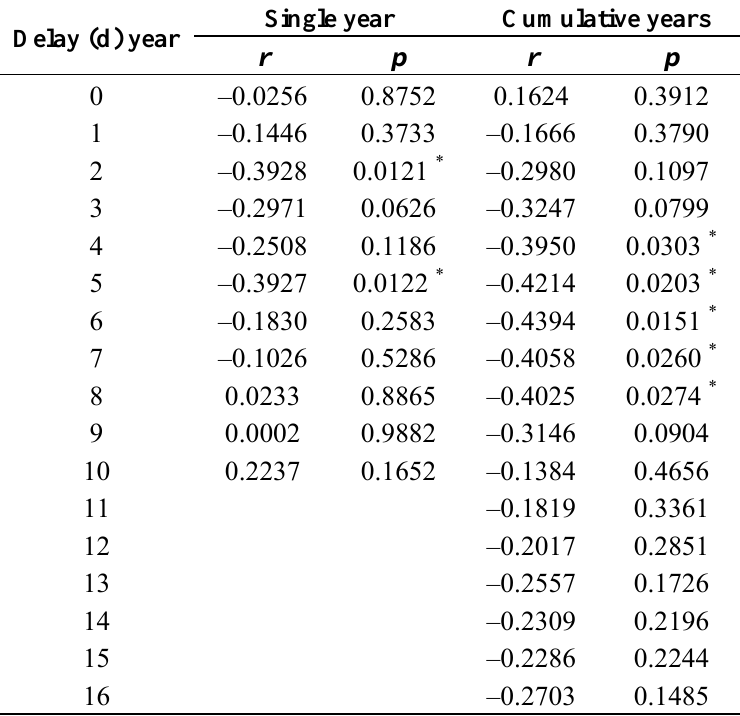
Table 2. Cross correlation coefficients between mortality and single and cumulative growing season